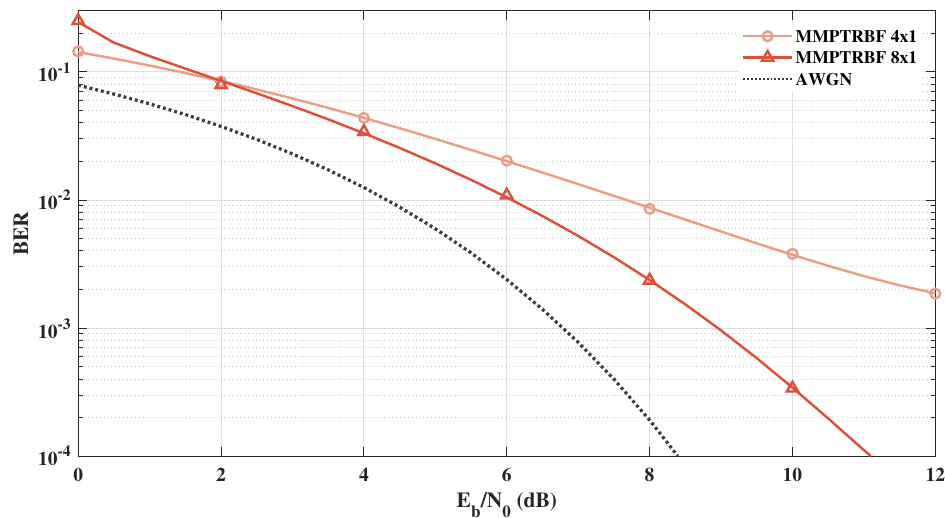
Figure 18. MMPTRBF with M T = 4, M T = 8, and M R = 1 antennas for 4-QAM modulation.